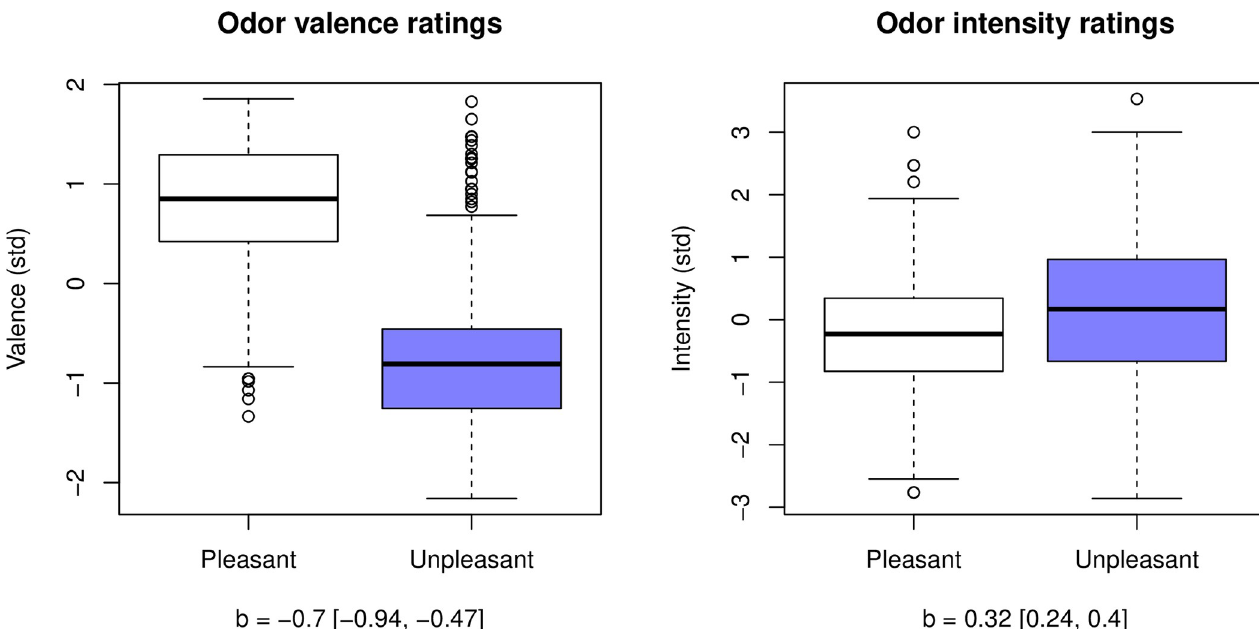
Fig 3. Standardized valence (left) and intensity (right) ratings for pleasant (white) and unpleasant (blue) odors. Black lines show medians, numbers in square brackets represent 94% HPDI for mean posterior estimate of the difference (b).